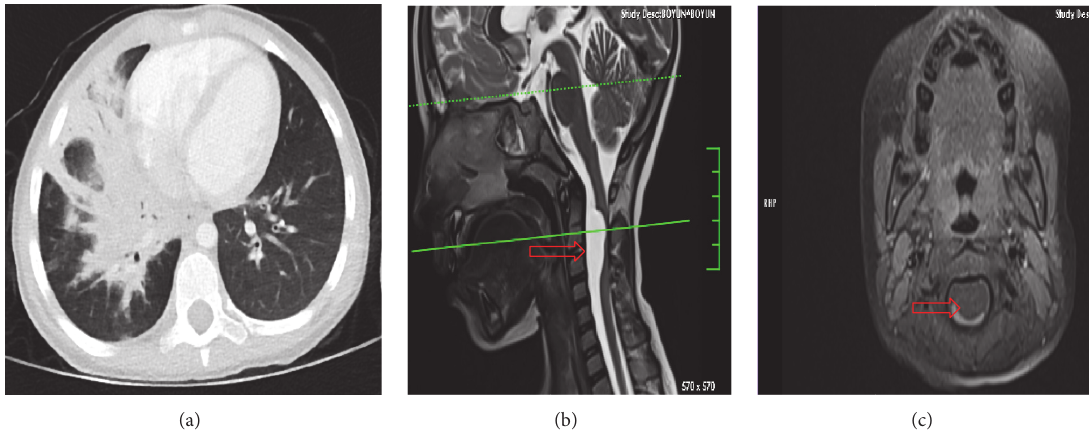
Figure 2: Thorax CT (b) and neck MR (b-c): right lung consolidation and cervical spine arachnoid cyst